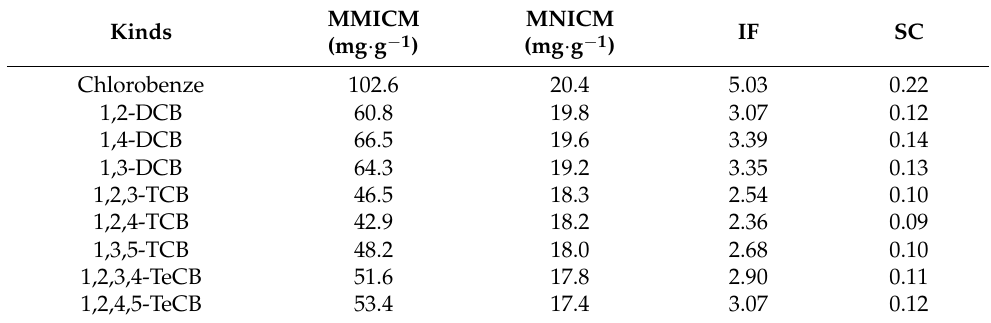
Table 1. Kinds of obtained